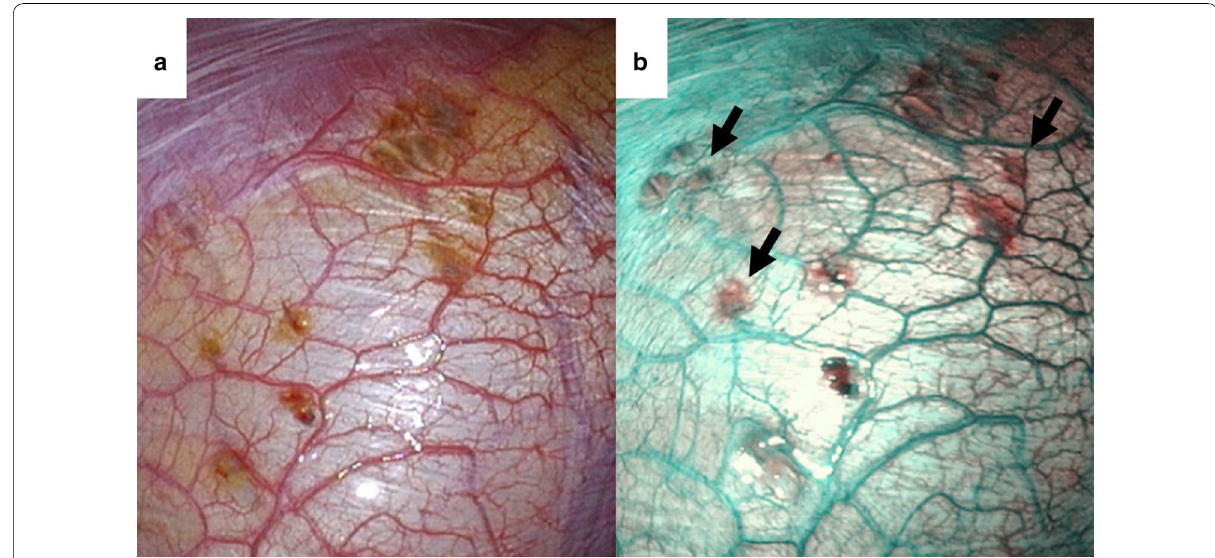
Fig. 1 Representative images of the diaphragm in case 1. Some brownish spots were more clearly visualized as dark green with NBI